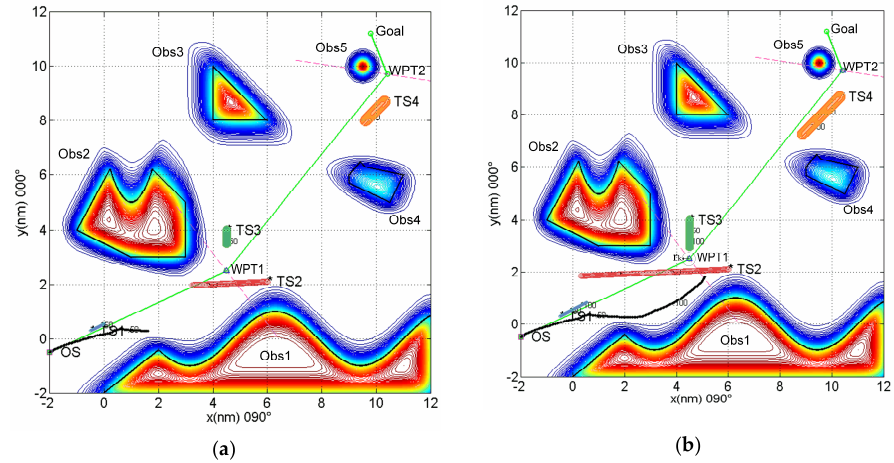
Figure 15. ( a ) The own ship takes a right turn 20° to starboard due to Obs1 to overtake and pass TS1 at a range of 0.3 nm. After that, the crossing situation with TS2 requires the own ship to give way, so that the own ship alters course 30° to starboard and passes clear Obs1 by at least 0.7 nm. ( b ) TS2 has been passed clear at a range of 1.6 nm. Without the influence of TS3, the own ship would alter course to port to approach WPT1 due to the large distance between the own ship and WPT1 (more than r k ), but doing this could go against Rules 15 & 17 of COLREGS and cause immediate danger with TS3. Therefore, the own ship keeps course not to port and not further to starboard due to the existence of the area obstacle Obs1 on the starboard side and passes TS3 at a safe distance of approximately 1.0 nm. Finally, the own ship crosses the angular bisector composed of the successive path legs and approaches the next waypoint WPT2.